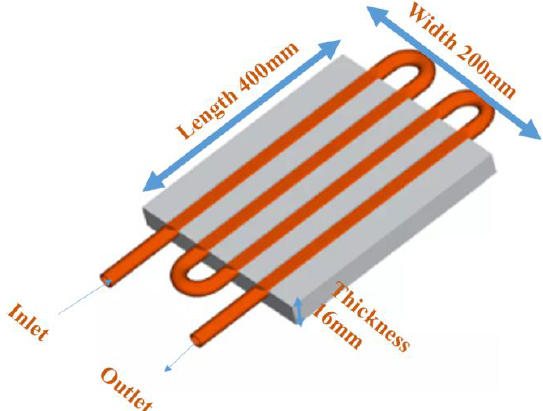
Figure 10. Proposed liquid cold plate for e-bike battery cooling. Table 5. Specifications of the liquid cold plate.